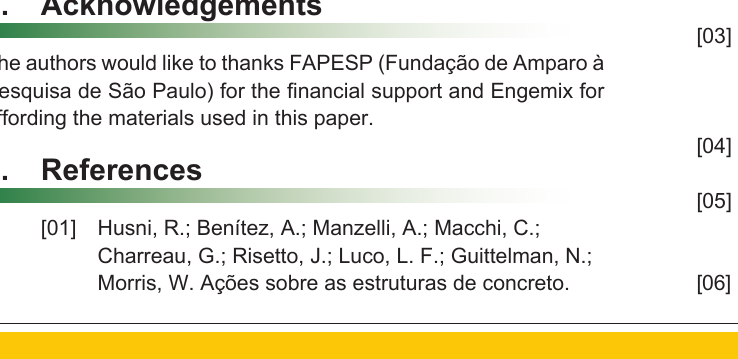
Table 7 – Coefficient of variation between experimental results and the prediction